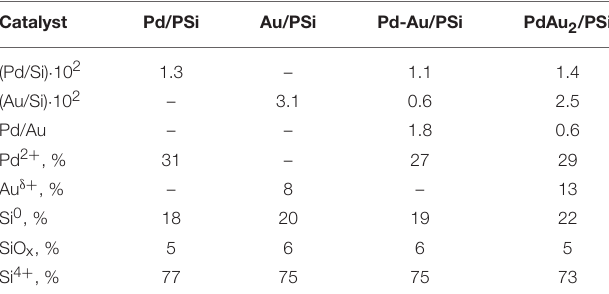
TABLE 3 | XPS data on the surface composition of the